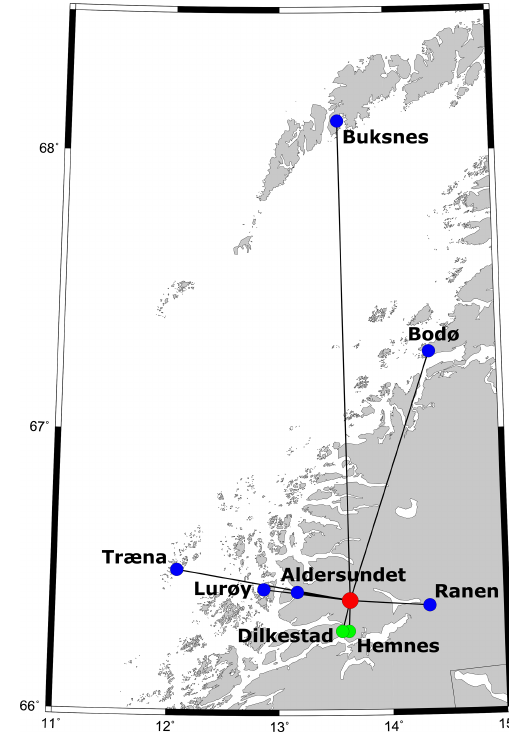
Figure 5. Landslides triggered by the 1819 Lurøy earthquake. The red dot is the epicentre of the event, blue dots are rockfalls, and green dots are landslides in clayey